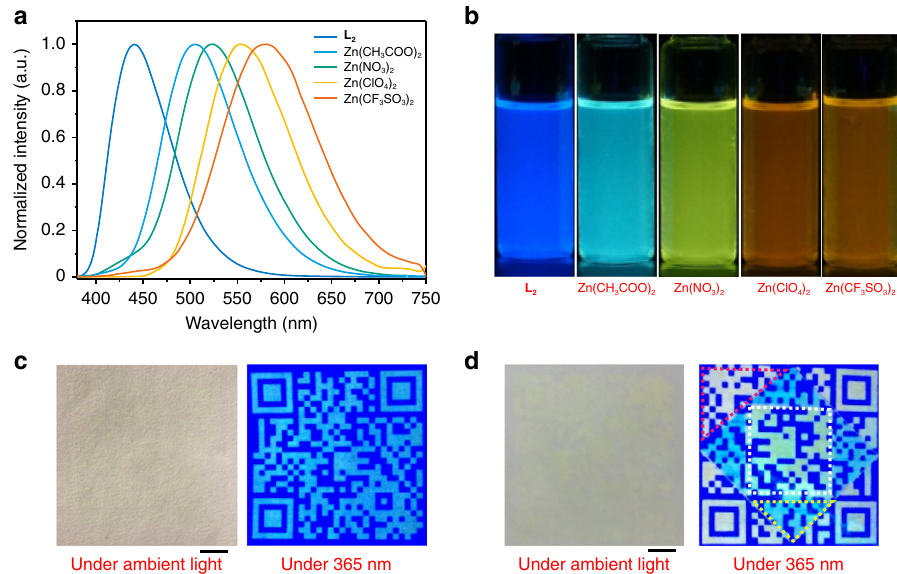
Fig. 4 Photoluminescent properties and security printing. a Room-temperature normalized photoluminescence spectra of L 2 and Zn(II) complexes in CH 2 Cl 2 (10 μ M). b Photographs of the emission colours of L 2 and Zn(II) complexes in CH 2 Cl 2 . c An image of QR code under daylight and UV light printed using a customized black inkjet cartridge fi lled with Zn(CH 3 COO) 2 aqueous solution. d A colourful image of QR code under ambient light and UV light printed using a customized tri-colour inkjet cartridge fi lled with Zn(CH 3 COO) 2 , Zn(NO 3 ) 2 and Zn(CF 3 SO 3 ) 2 aqueous solution. Scale bar = 1